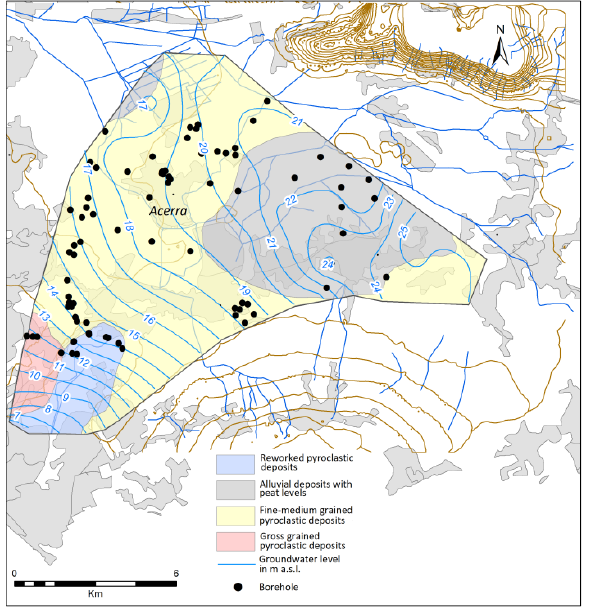
Figure 3. Hydrogeological map of the Campanian Plain-Acerra area. The grey line delimitates the shallow aquifer. Original drawing.